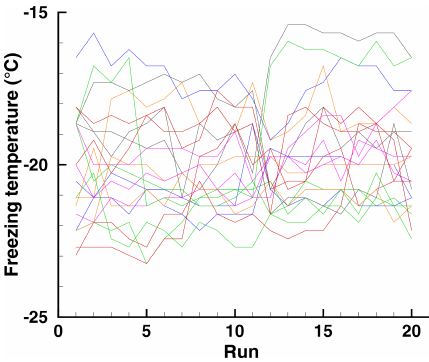
Figure 18. Spiderweb diagram of freezing temperatures of 20 drops of a soil suspension in 20 runs from a subset of data in Vali